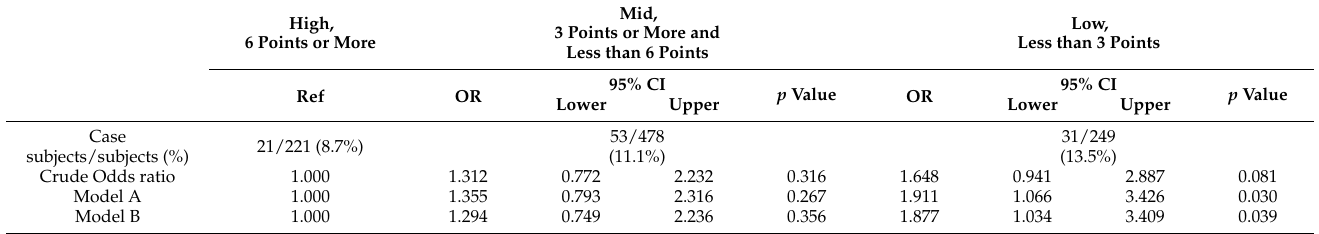
Table 5. Odds ratio for frailty during one-year follow-up of subjects with non-frailty at baseline. High, 6 Points or More